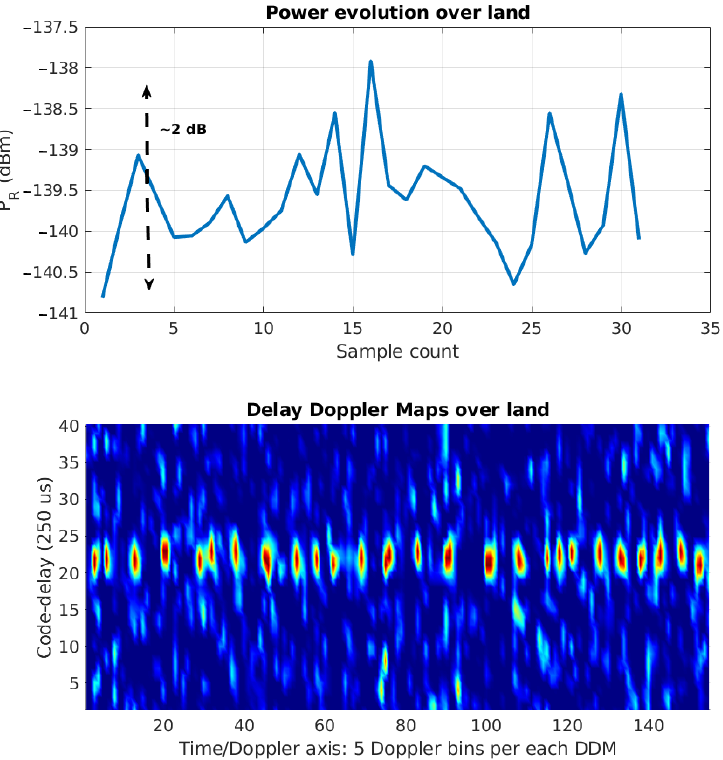
Figure 18. Received power and DDM track for the selected track at the North of Russia, collected on the 12 October 2020. The black box in Figure 17 indicates the selected region shown in this